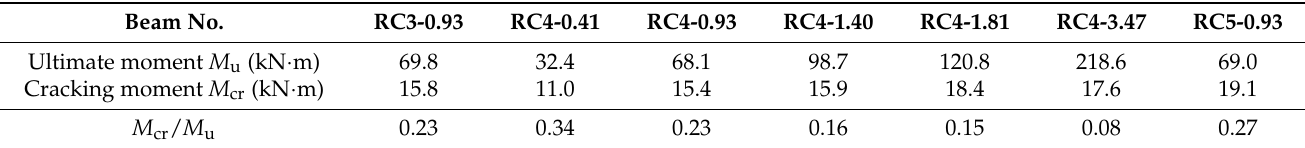
Table 4. Test results of cracking and ultimate moments of test